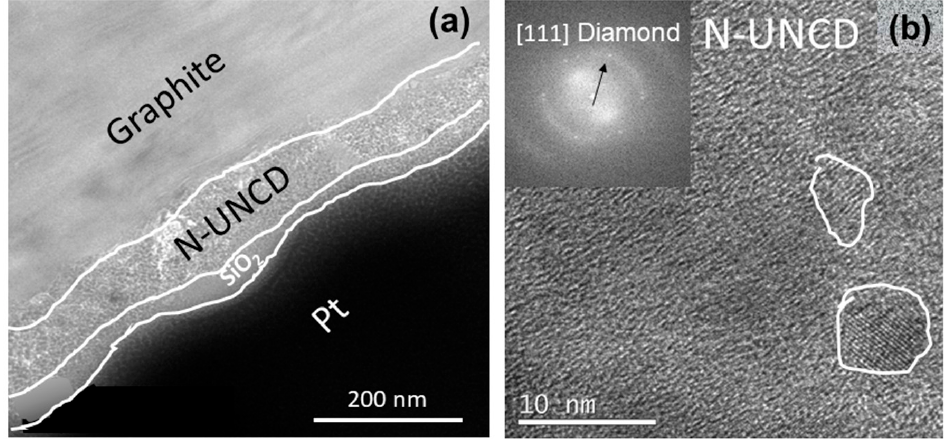
Figure 5. High-resolution TEM of N-UNCD grown on graphite. ( a ) Cross section TEM ( b ) high-resolution image with FFT diffraction grating showing the plane distance corresponding to [111] diamond plane.